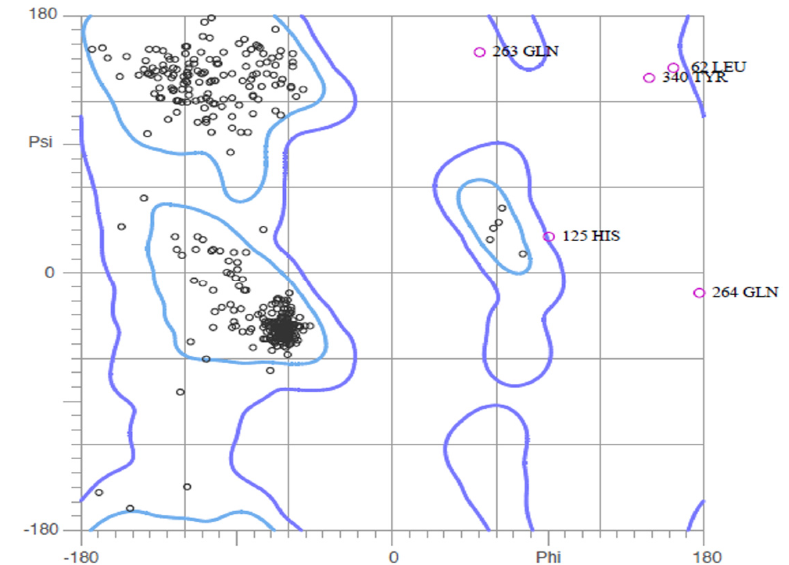
Figure 3. Ramachandran